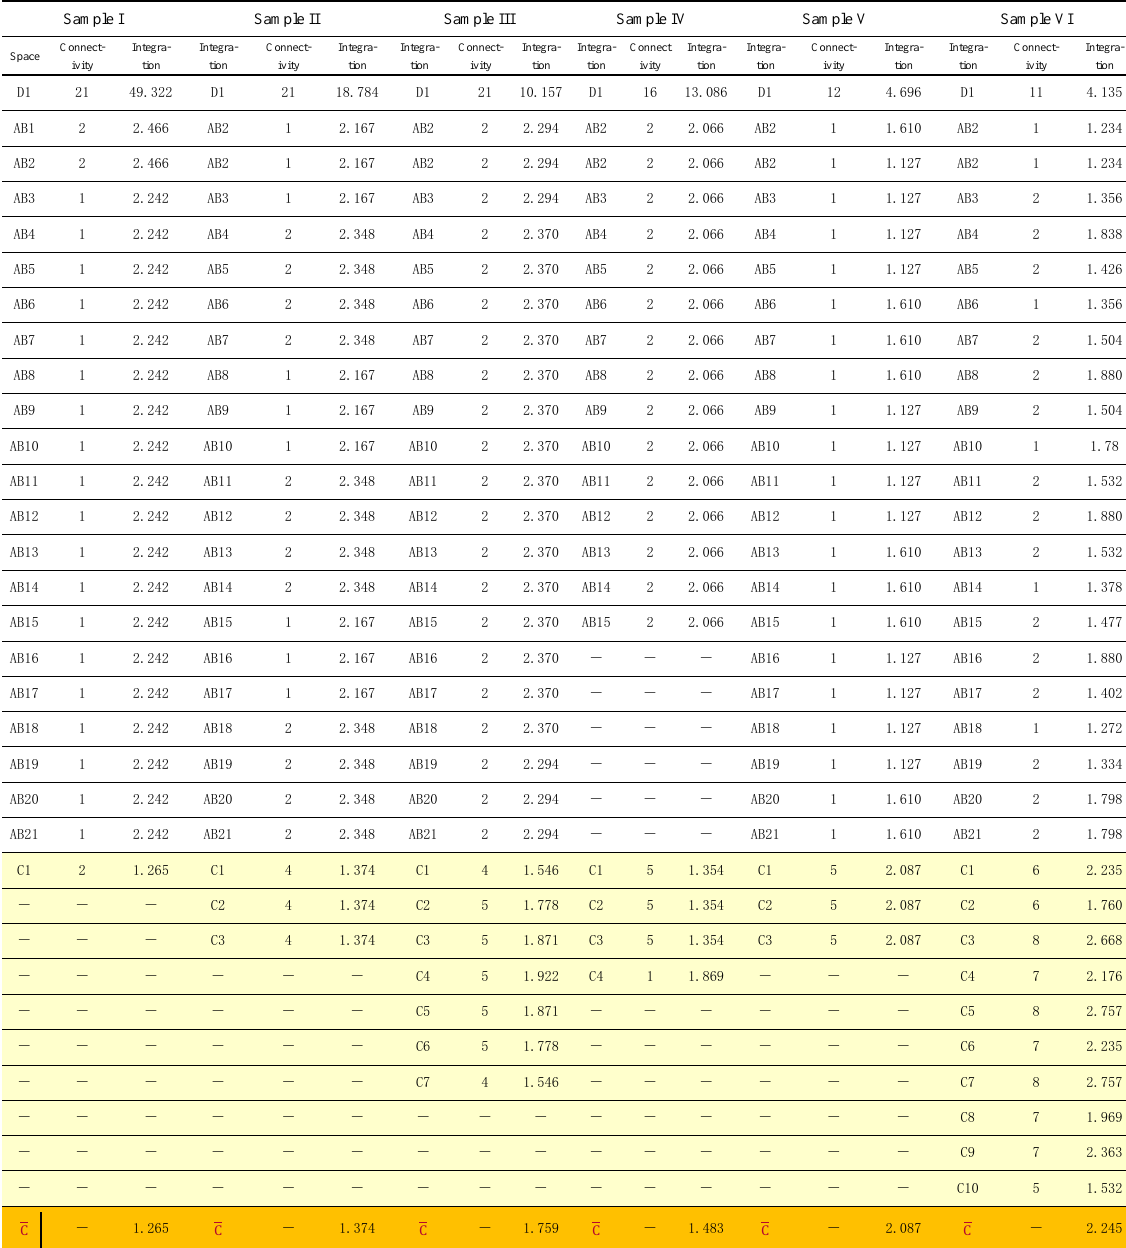
Table 5 Connectivity and integration of sample